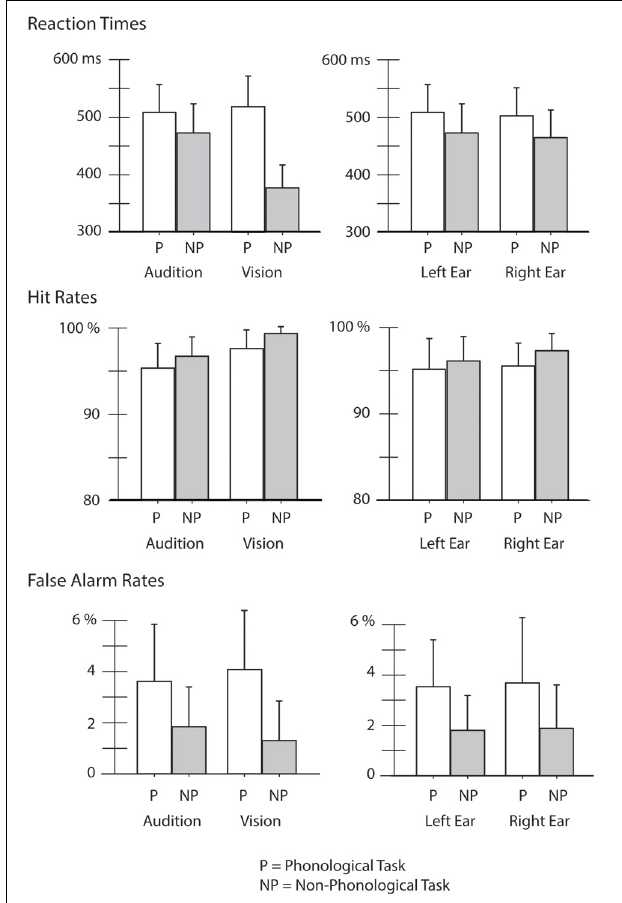
FIGURE 2 | Reaction times (RTs), hit rates (HRs), and false-alarm rates (FaRs) in different experimental conditions. Performance is compared between the auditory and visual tasks (Audition vs. Vision) while participants performed a phonological (P) or non-phonological task (NP) in the attended modality (for Audition data for the left-ear and right-ear tasks were combined) and within the auditory domain between the left-ear and right-ear tasks while participants performed an auditory phonological task (P) and an auditory non-phonological task (NP). calculated for them. Hit rates (HRs) were calculated as the